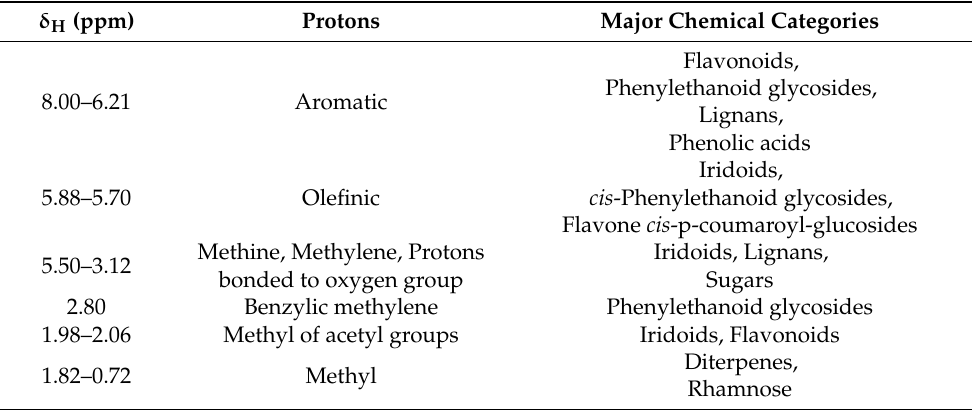
Table 1. The main proton chemical shifts of the 1 H-NMR spectrum of the total EtOAc residue correlated to its observed major chemical